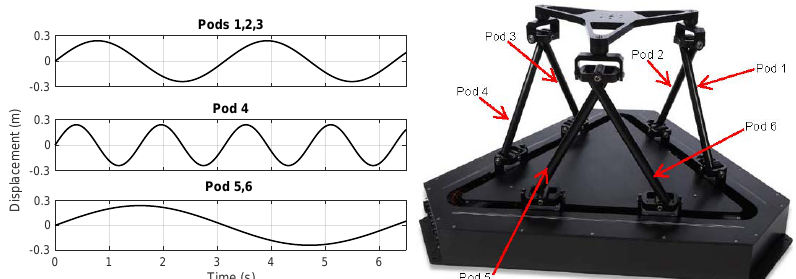
Figure 6. Hexapod links programmed motion to produce the exogenous disturbances to the Furuta pendulum. This Figure only shows 6 s of the external perturbation, to clarify the hexapod movement (see the video: https://youtu.be/C8f1orF5uDo).